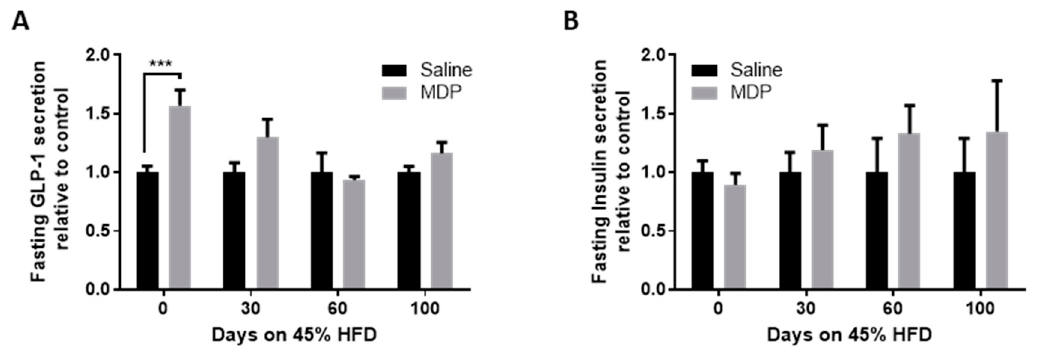
Figure 6. Elevated fasting GLP-1 is lost with the development of hyperglycemia. Fasting GLP-1 ( A ) and insulin ( B ) were measured after mice received two IP injections of MDP (5 mg/kg) or saline, n = 7 – 19 mice per group. Results analyzed by two-way ANOVA with Sidak post-hoc test. *** p < 0.001. Values shown as mean ± SEM.